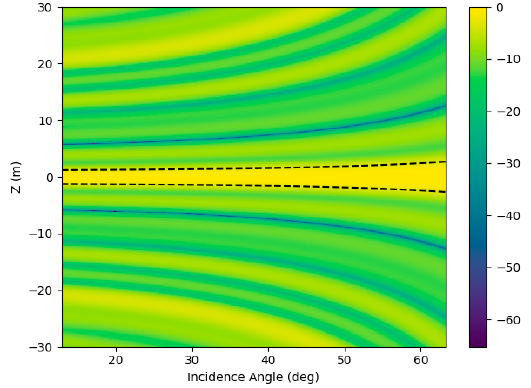
Figure 4. Projected impulse response as a function of incidence angle after Fourier beamforming.